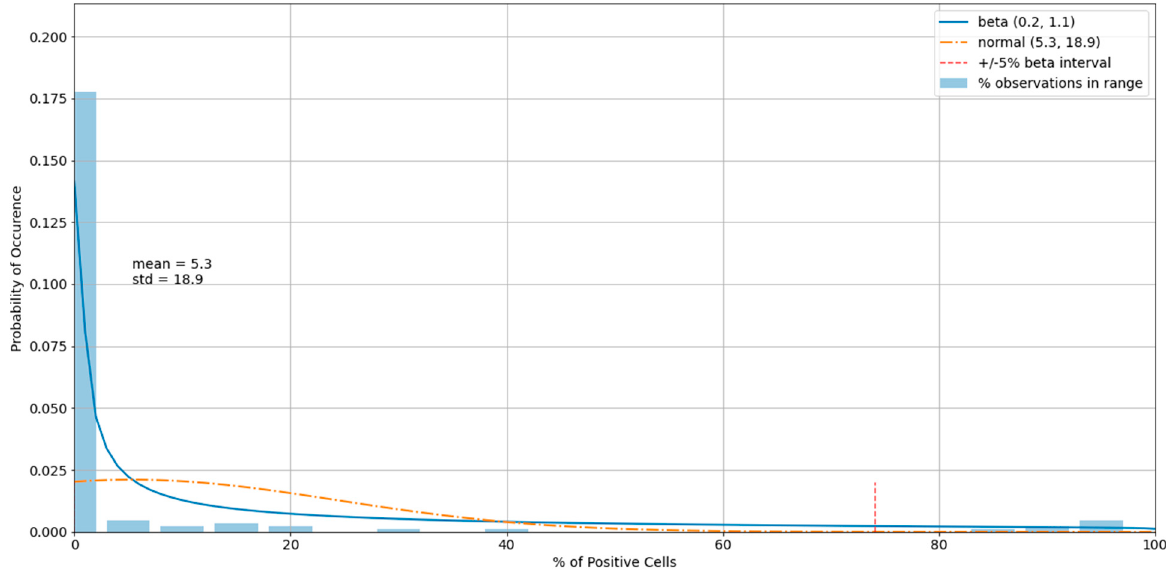
Figure 7. A histogram of the variability of cell control observations with fitted normal and beta distributions.